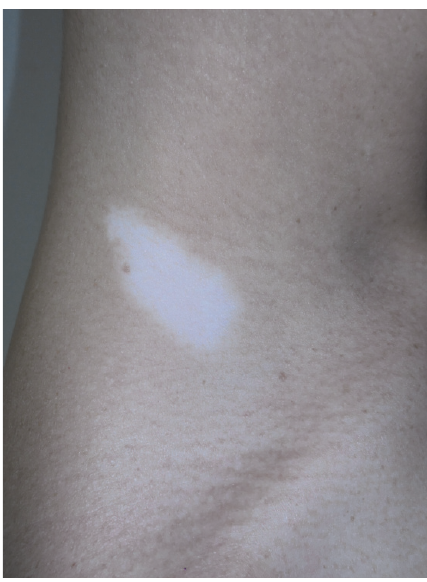
Figure 1: Depigmented patch with leukotrichia right inferolateral neck.